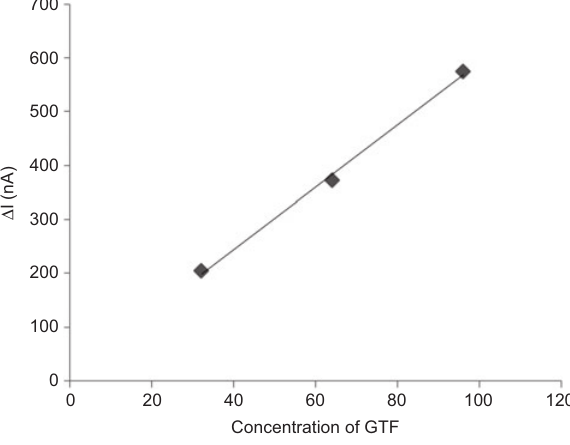
Figure 8 The relationship between Δ I and concentration of gatifl oxacin.